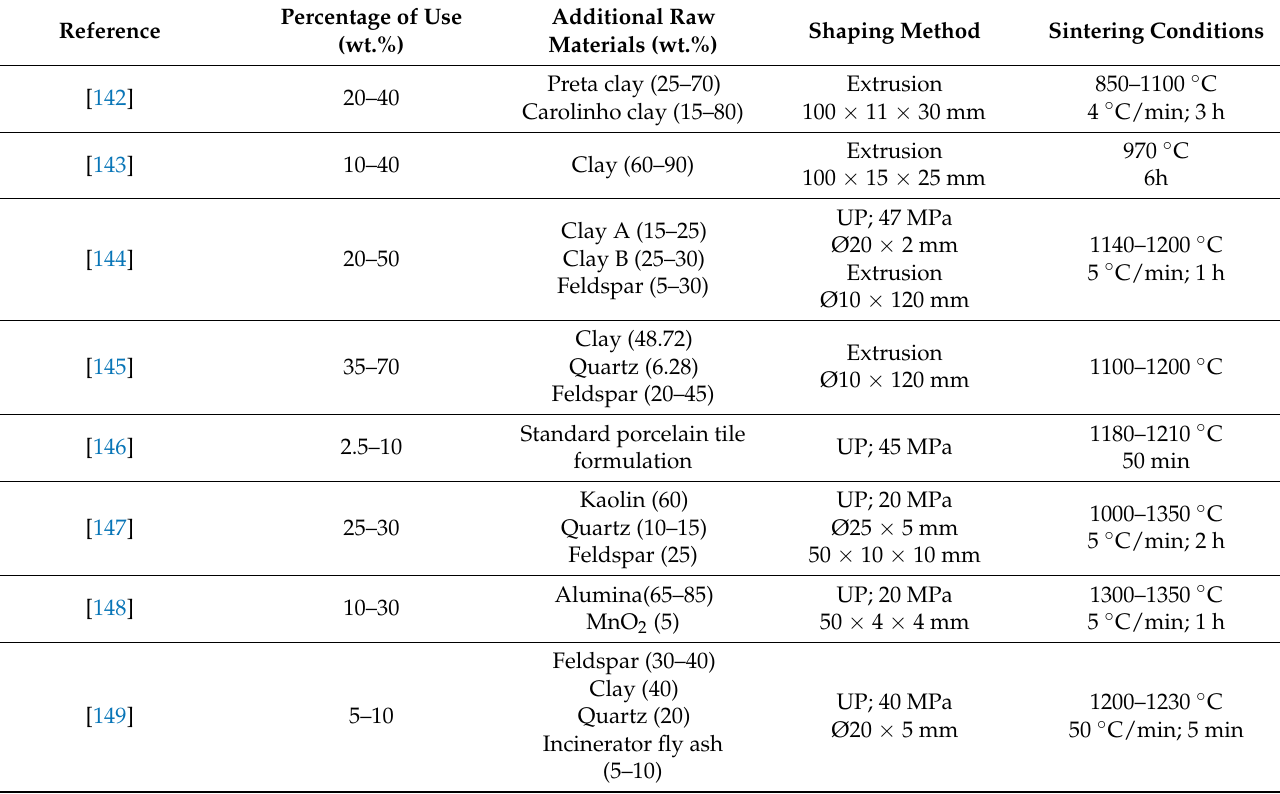
Table 20. Experimental conditions used in the development of mullite-based materials from granite waste.